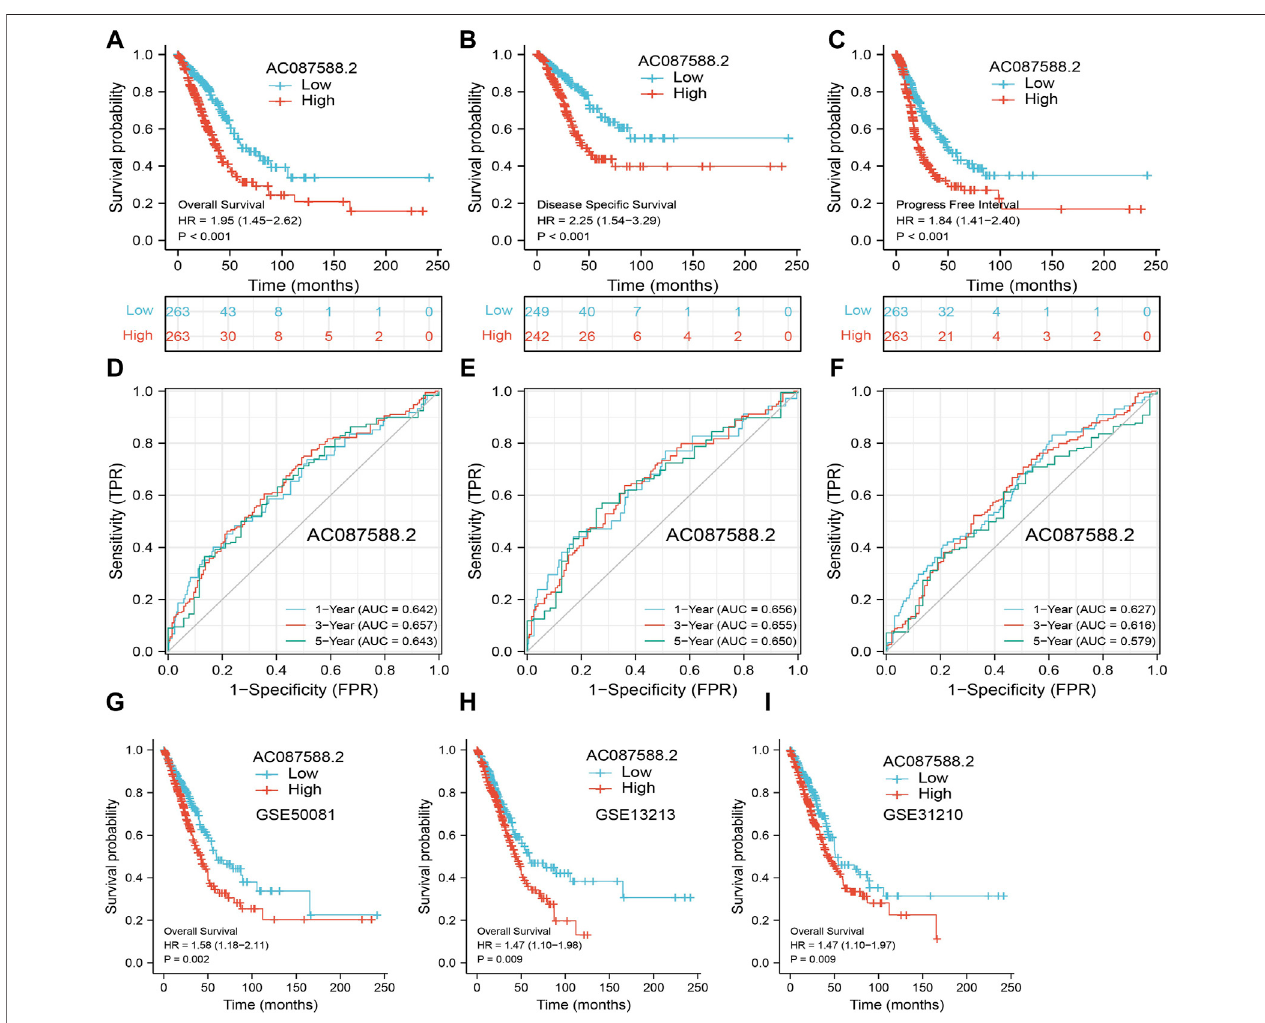
FIGURE 3 | ROC and Kaplan – Meier curves of AC087588.2. (A – C) OS, DSS, and PFS of AC087588.2 in LUAD determined using the TCGA-LUAD dataset. (D – F) ROC curve of AC087588.2 in LUAD determined using the TCGA-LUAD dataset. (G – I) Validation of overall survival of AC087588.2 in lung cancer by GEO datasets.